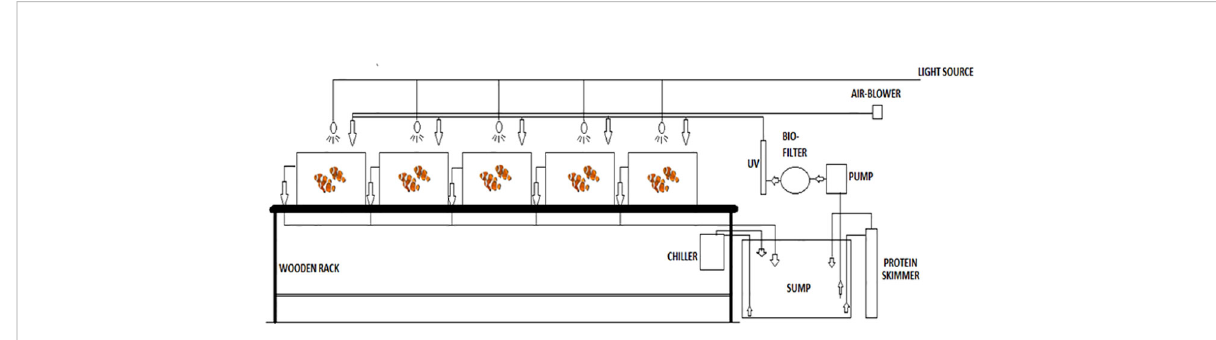
FIGURE 2 Schematic diagram of recirculating aquaculture system (RAS) for broodstock maintenance of designer clown fi